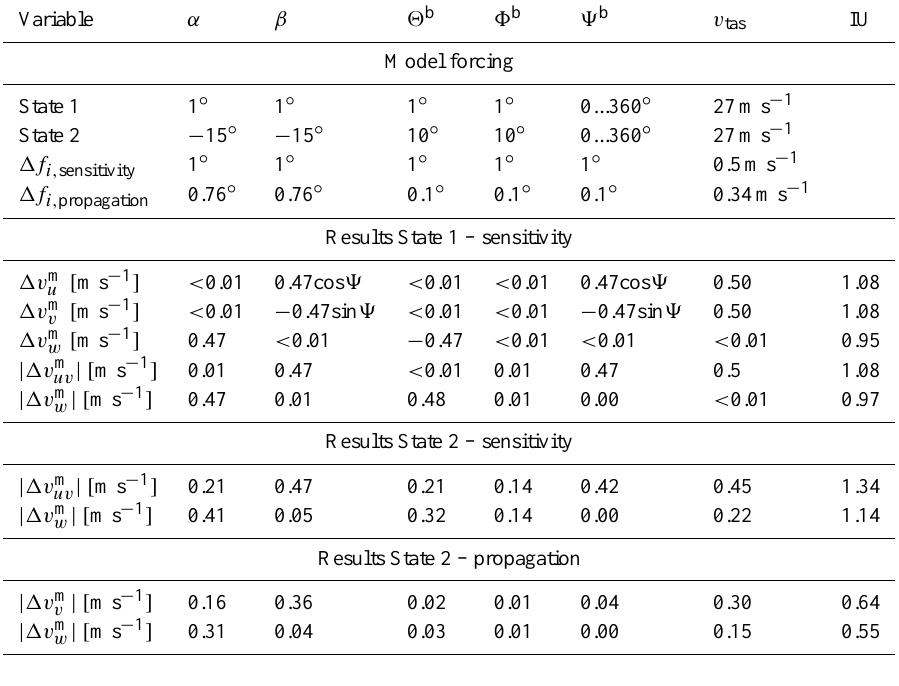
Table 4. Input uncertainty (IU) from the linear uncertainty propagation model Eq. (B1). For the sensitivity analysis the model was forced with two different reference states, State 1 with small and State 2 with enhanced flow ( α , β ) and attitude ( 2 b , 8 b , 9 b ,) angles. Both states were inferred similar uncertainty quantities 1f i in α , β , 2 b , 8 b , 9 b , and true airspeed ( v tas ). After calibration Step B the reference State 2 was used for the uncertainty propagation: the actual uncertainties in (a) the flow computation ( α , β and v tas , Table 5), and (b) the sensor alignment ( 2 b , 8 b , 9 b ) were inferred. Additional information is given in Sect. 4.1.